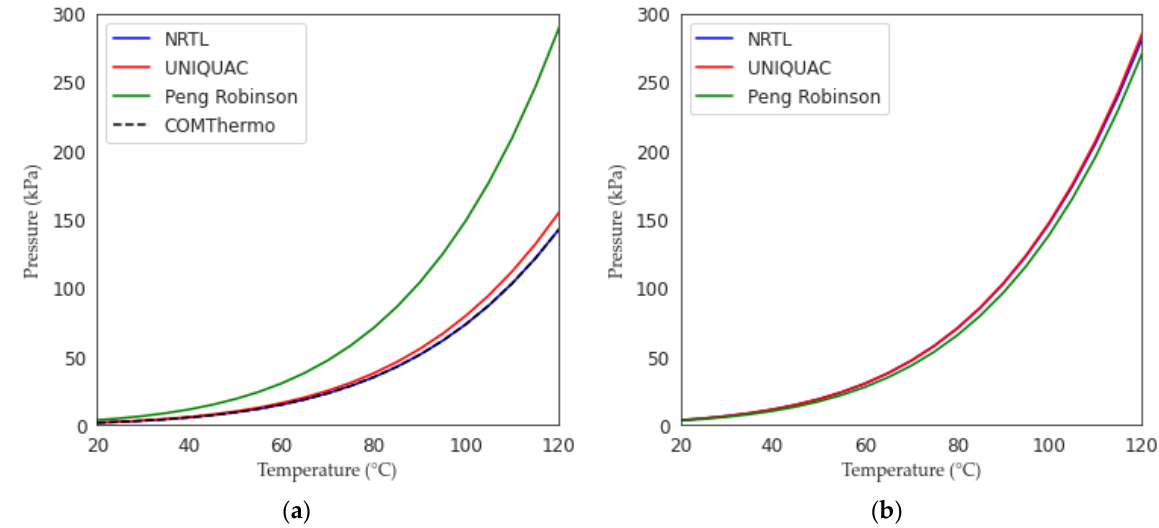
Figure 3. Bubble Point Pressure Calculations with Different Thermodynamic Models for ( a ) HYSYS V9 and ( b ) Aspen Plus V9. Note: 0.5 Octane/0.5 water molar fractions. Table 3. Comparison between HYSYS V9 and Aspen Plus V9.